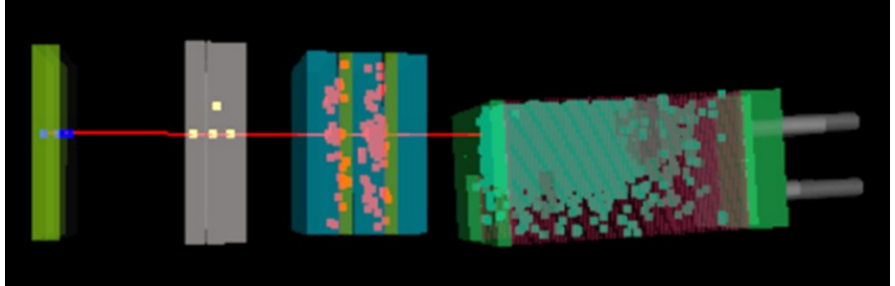
Figure 7. An event display of a simulated 100 GeV electron passing through the tracker station and the pre-shower station, before showering in the ECAL.